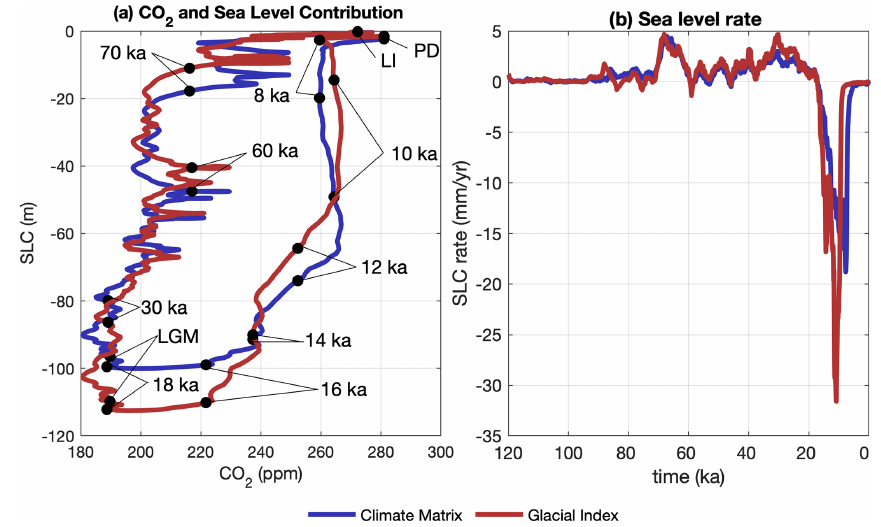
Figure 10. Sea level contribution plotted against CO 2 concentrations (a) . The sea level contribution rate during the LGC (b) . LI indicates last interglacial; PD indicates present